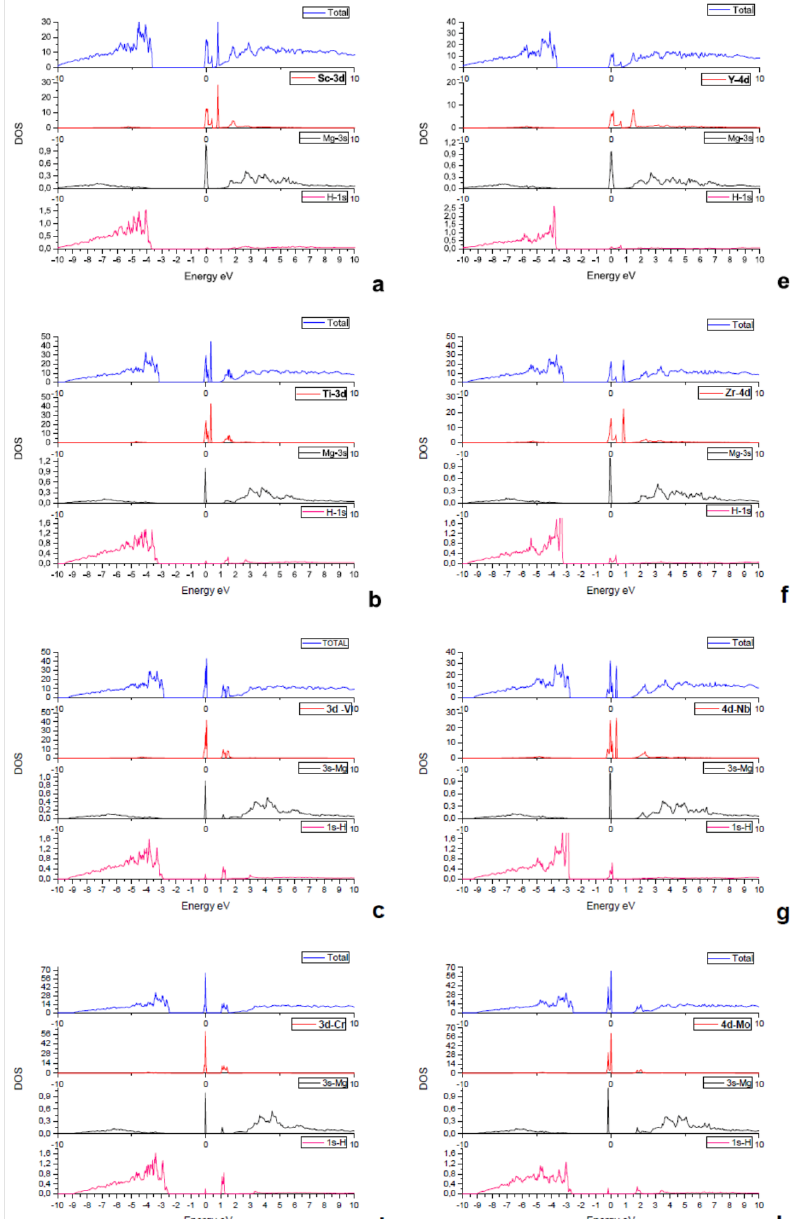
Figure 12. Total and partial density of state (T-DOS and P-DOS) of the systems. ( a ) Mg 15 ScH 32 . ( b ) Mg 15 TiH 32 . ( c ) Mg 15 VH 32 . ( d ) Mg 15 CrH 32 . ( e ) Mg 15 YH 32 . ( f ) Mg 15 ZrH 32 . ( g ) Mg 15 NbH 32 . ( h ) Mg 15 MoH 32 . ( a – h ) Reproduced with permission [26]. Copyright 2016,